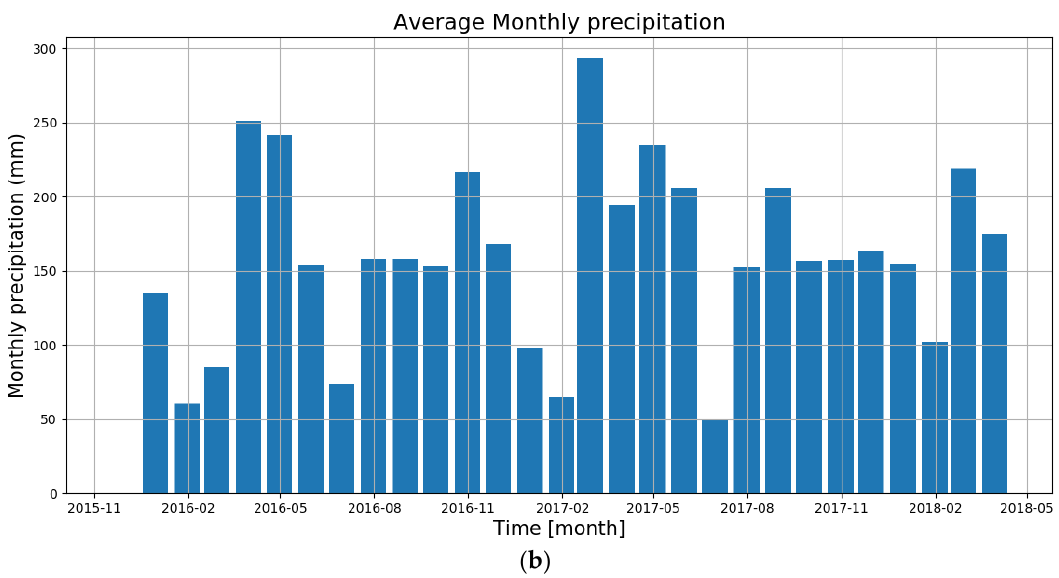
Figure 4. Precipitation records during the study period. These data were constructed from information from two pluviometric stations within a 2 km radius of the study site. Raw data were provided by the Early Warning System of Medellín and the Aburrá Valley (SIATA, by its acronym in Spanish). ( a ) Daily precipitation; ( b ) monthly precipitation.